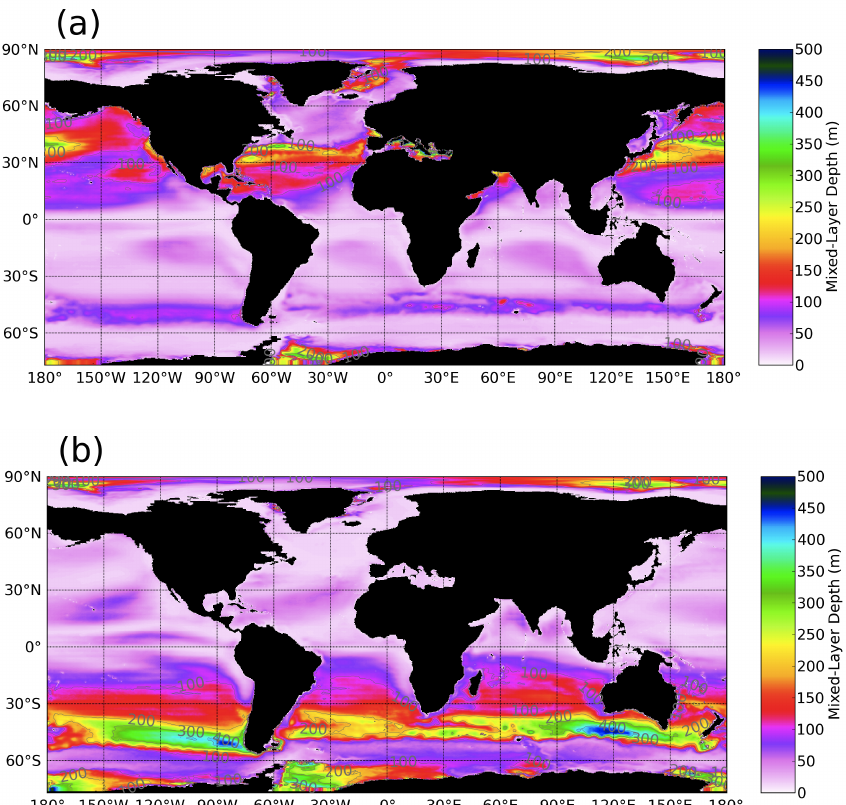
Fig. 6. Maps of (a) the boreal winter (JFM) and (b) the boreal summer (JAS) mixed layer depth (m) computed in the eddy-permitting